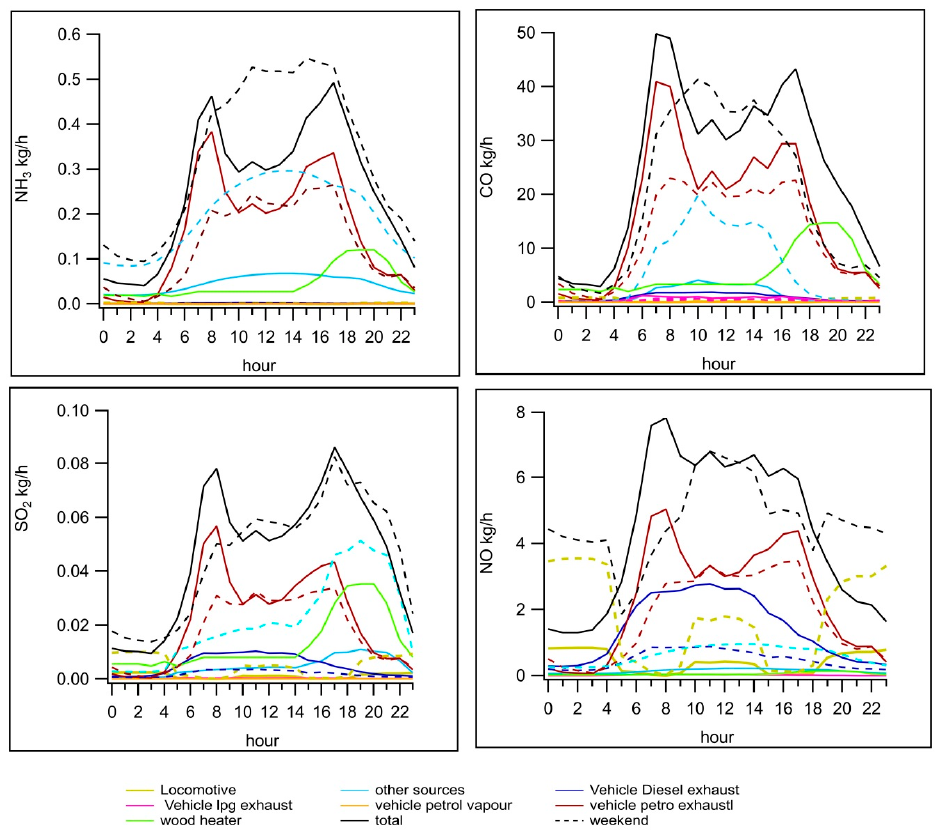
Figure 9. Emissions estimates and sources for NH 3 , CO, NO and N 2 O from the GMR2008 inventory for 2017 at the measurement location [53].